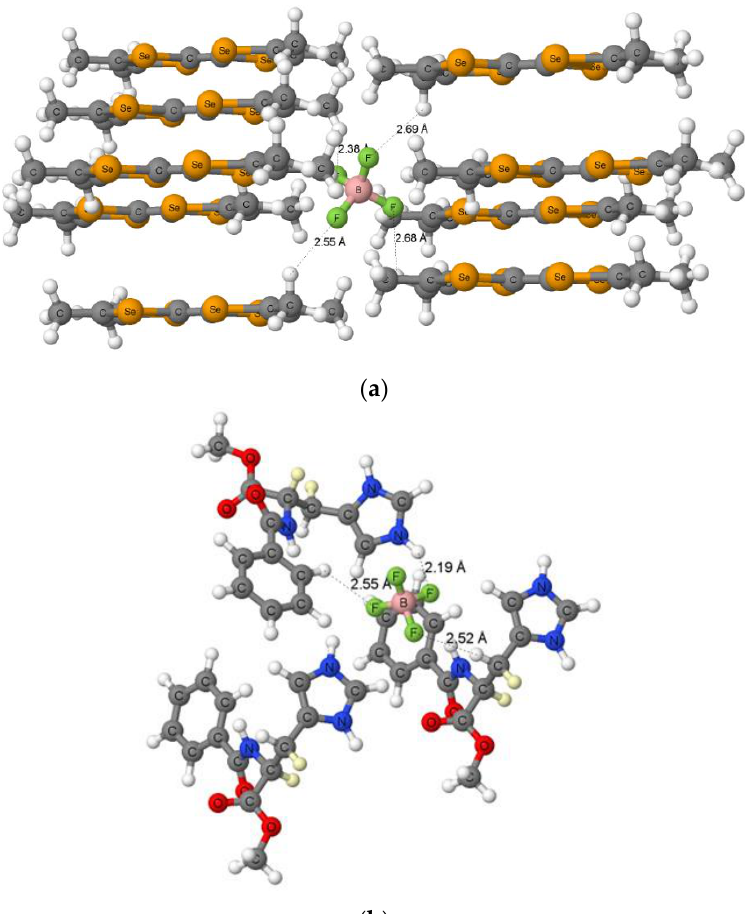
Figure 1. The fragment of the crystal structure of ( a ) bis(tetramethyl-tetraselenafulvalenium) tetrafluoroborate, BIXBIT03 refcode, reference 35, and ( b ) (R)-dideutero methyl N-benzoyl -3-(1H- imidazol-3-ium-5-yl)alaninate tetrafluoroborate, SUXHID01 refcode, reference 36, H…F distances are